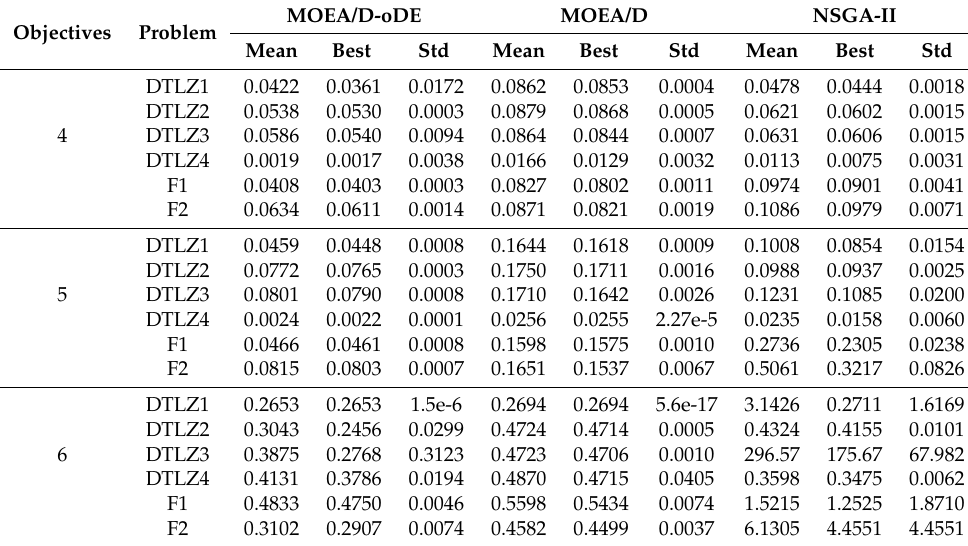
Table 4. Statistics of the IGD metric obtained by MOEA/D-oDE, MOEA/D and NSGA-II on the test problems.